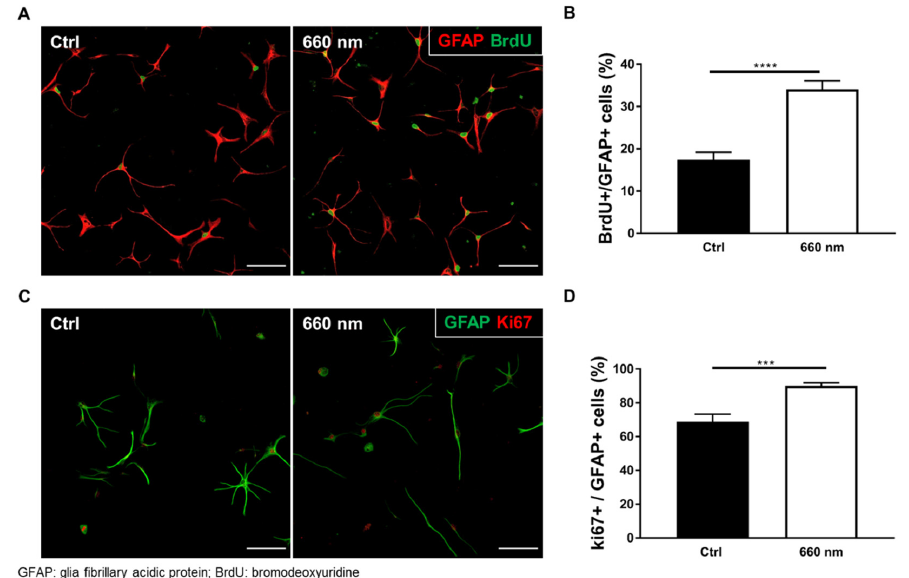
Figure 4. Astrocyte Proliferation was Promoted by 660-nanometer LED Irradiation. ( A ) Confocal image showing immunofluorescent staining (red, GFAP (astrocytes); green, BrdU (DNA duplication)) (scale bar: 100 μ m) ( B ) The percentage of BrdU- and GFAP-positive cells was significantly increased by 660-nanometer LED irradiation (Ctrl vs. 660 nm; n = 58 vs. 55, **** p < 0.0001). ( C ) Confocal image showing immunofluorescent staining (red, Ki67 (proliferation); green, GFAP (astrocytes)) (scale bar: 100 μ m). ( D ) The percentage of Ki67- and GFAP-positive cells was significantly increased by LED irradiation ( n = 45, *** p < 0.001).